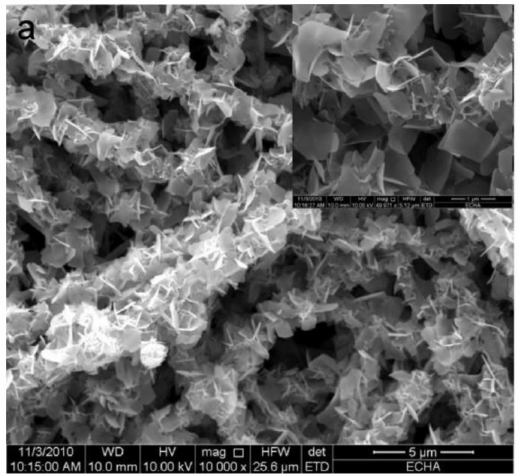
Figure 6. Surface of an electrospun cellulose scaffold mineralized in phosphate buffer saline for 1 week. Inset images reveal the higher magnification of the flake-like, high-surface-area, Ca–P miner- als. Adapted with permission form ref. [89]. Copyright 2012